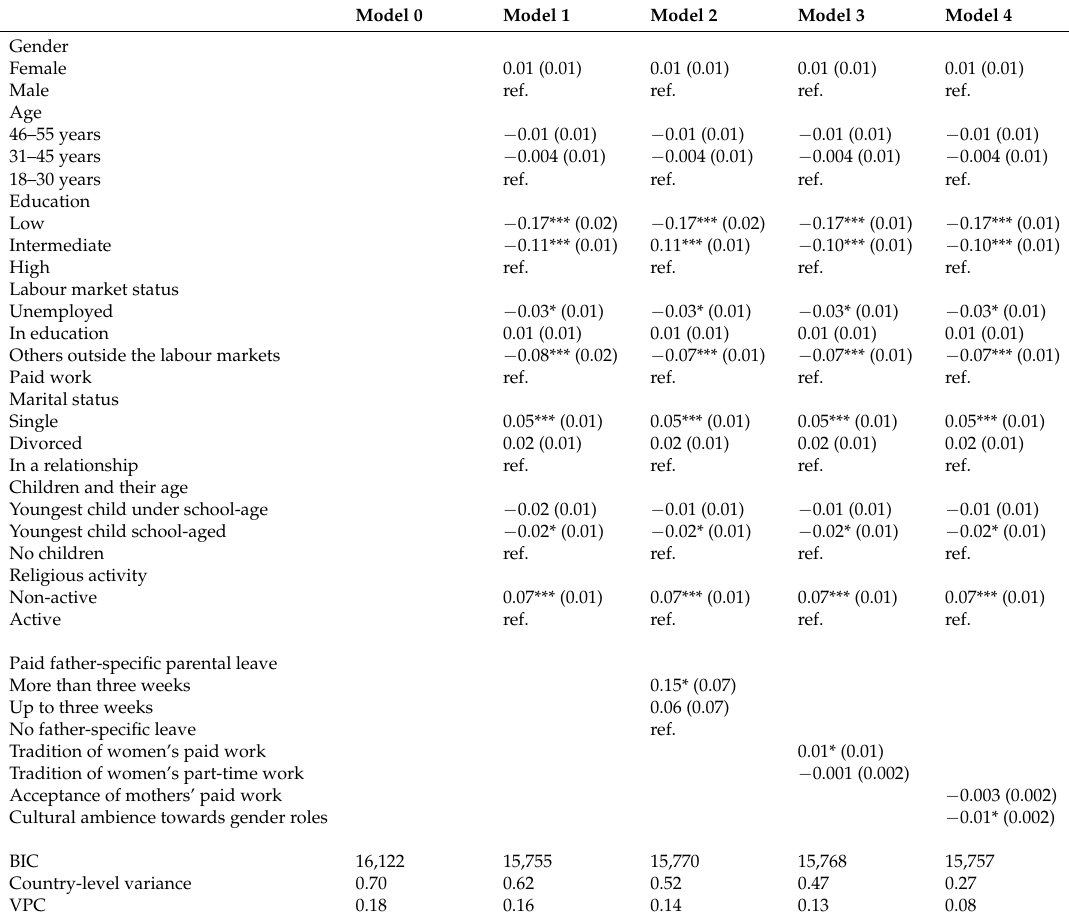
Table 2. Logistic multilevel regression analyses of attitudes to the equal earner-carer model, average marginal effects, and statistical significances (standard